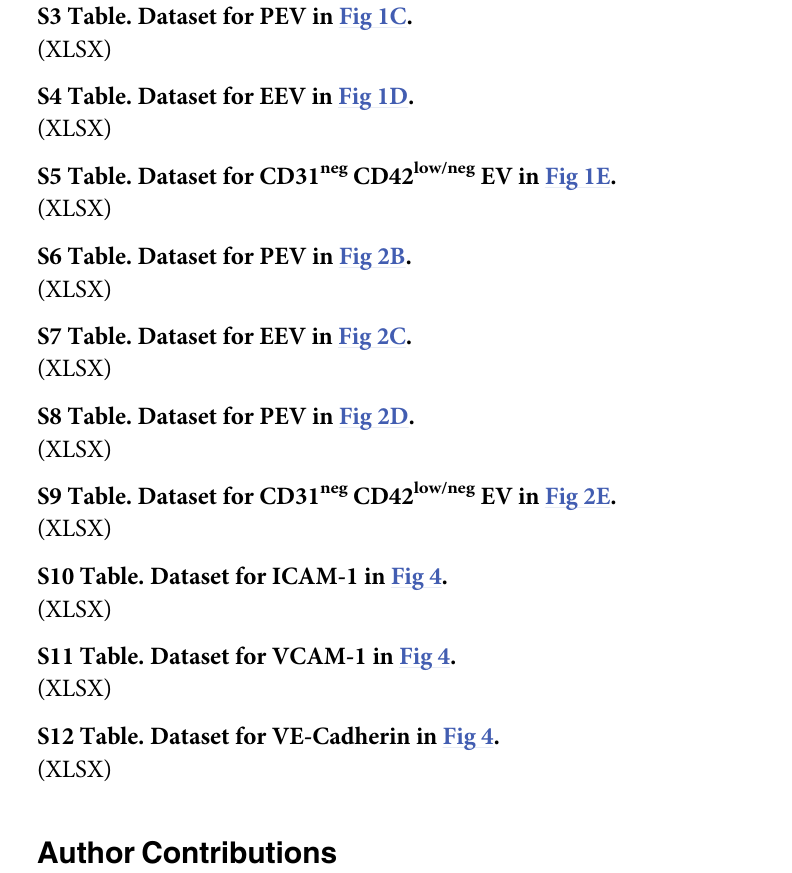
S10 Table. Dataset for ICAM-1 in Fig 4. S11 Table. Dataset for VCAM-1 in Fig 4. S12 Table. Dataset for VE-Cadherin in Fig